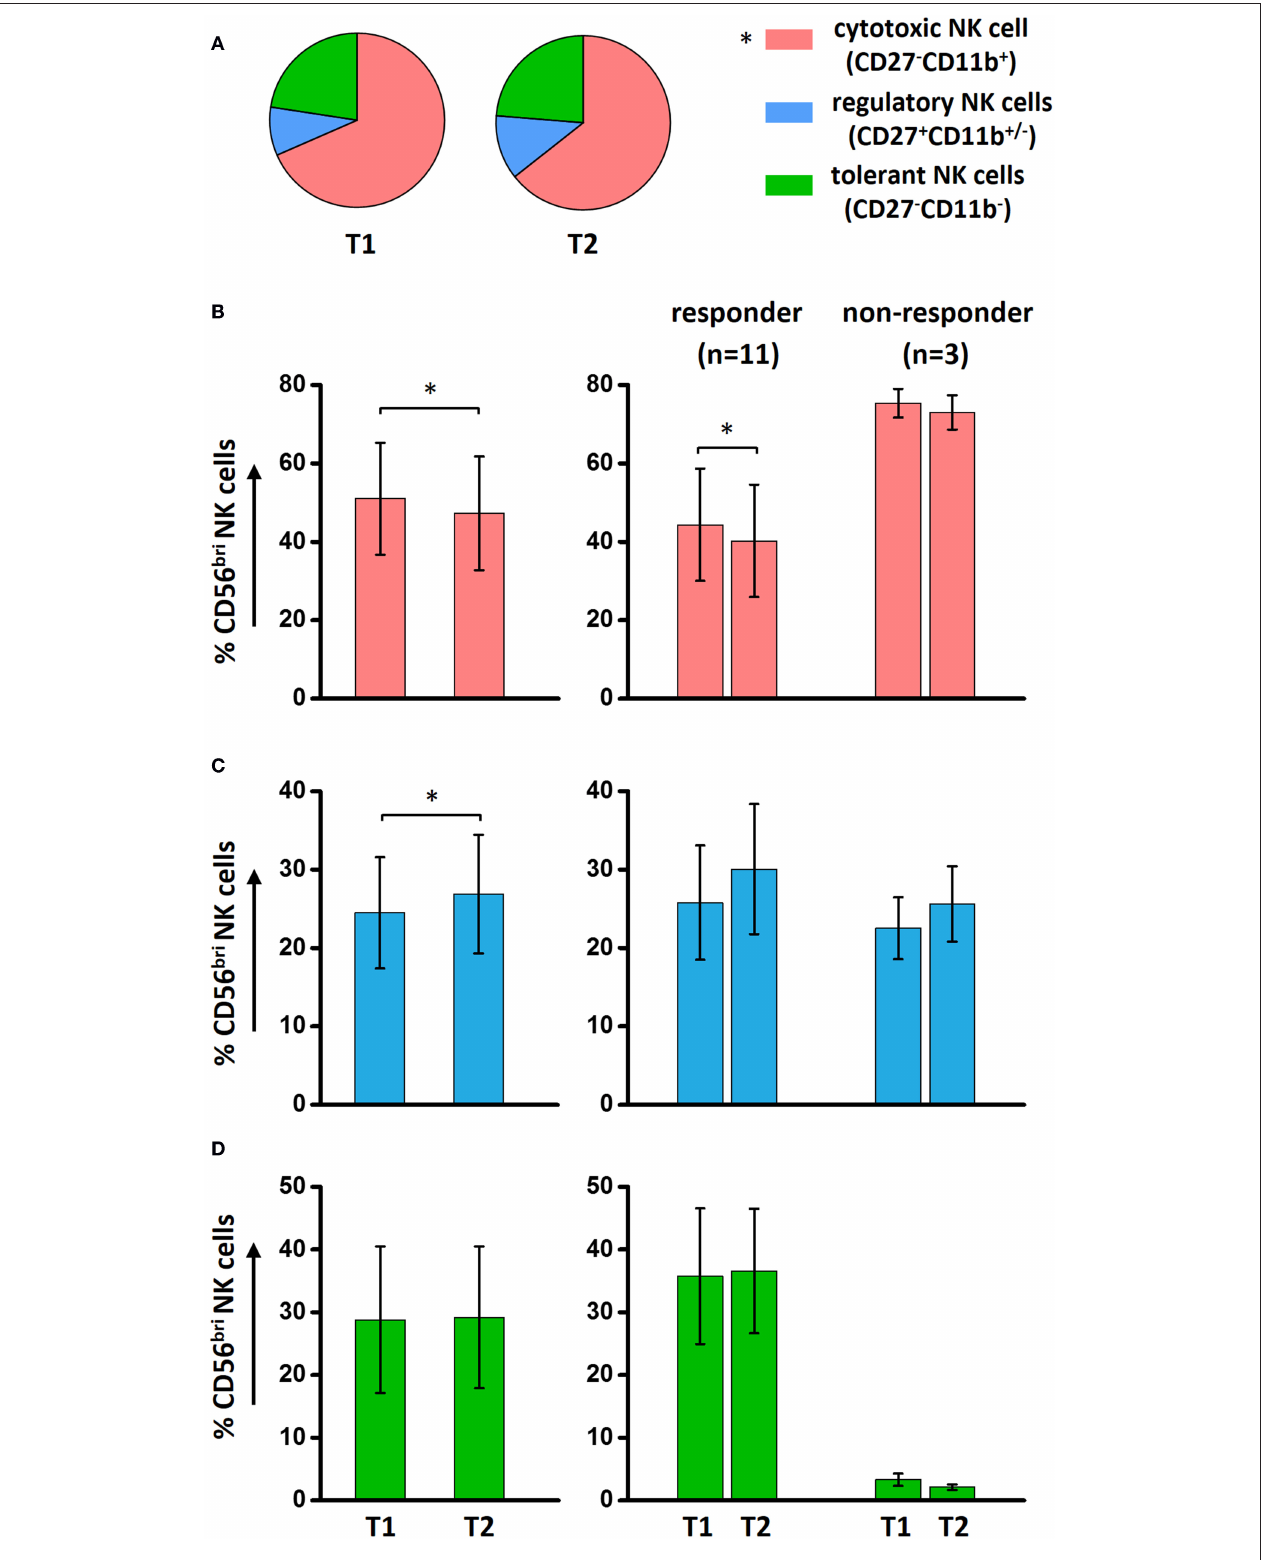
FIGURE 5 | Effect of ECP on functional NK subsets. ECP could reduce significantly the total cytotoxic NK cells while keeping the total regulatory and tolerant NK cells stable in aGVHD patients (A) . However, within the CD56 bri NK subsets, a dramatically decrease of cytotoxic NK cells (B) in conjunction with an increase of regulatory